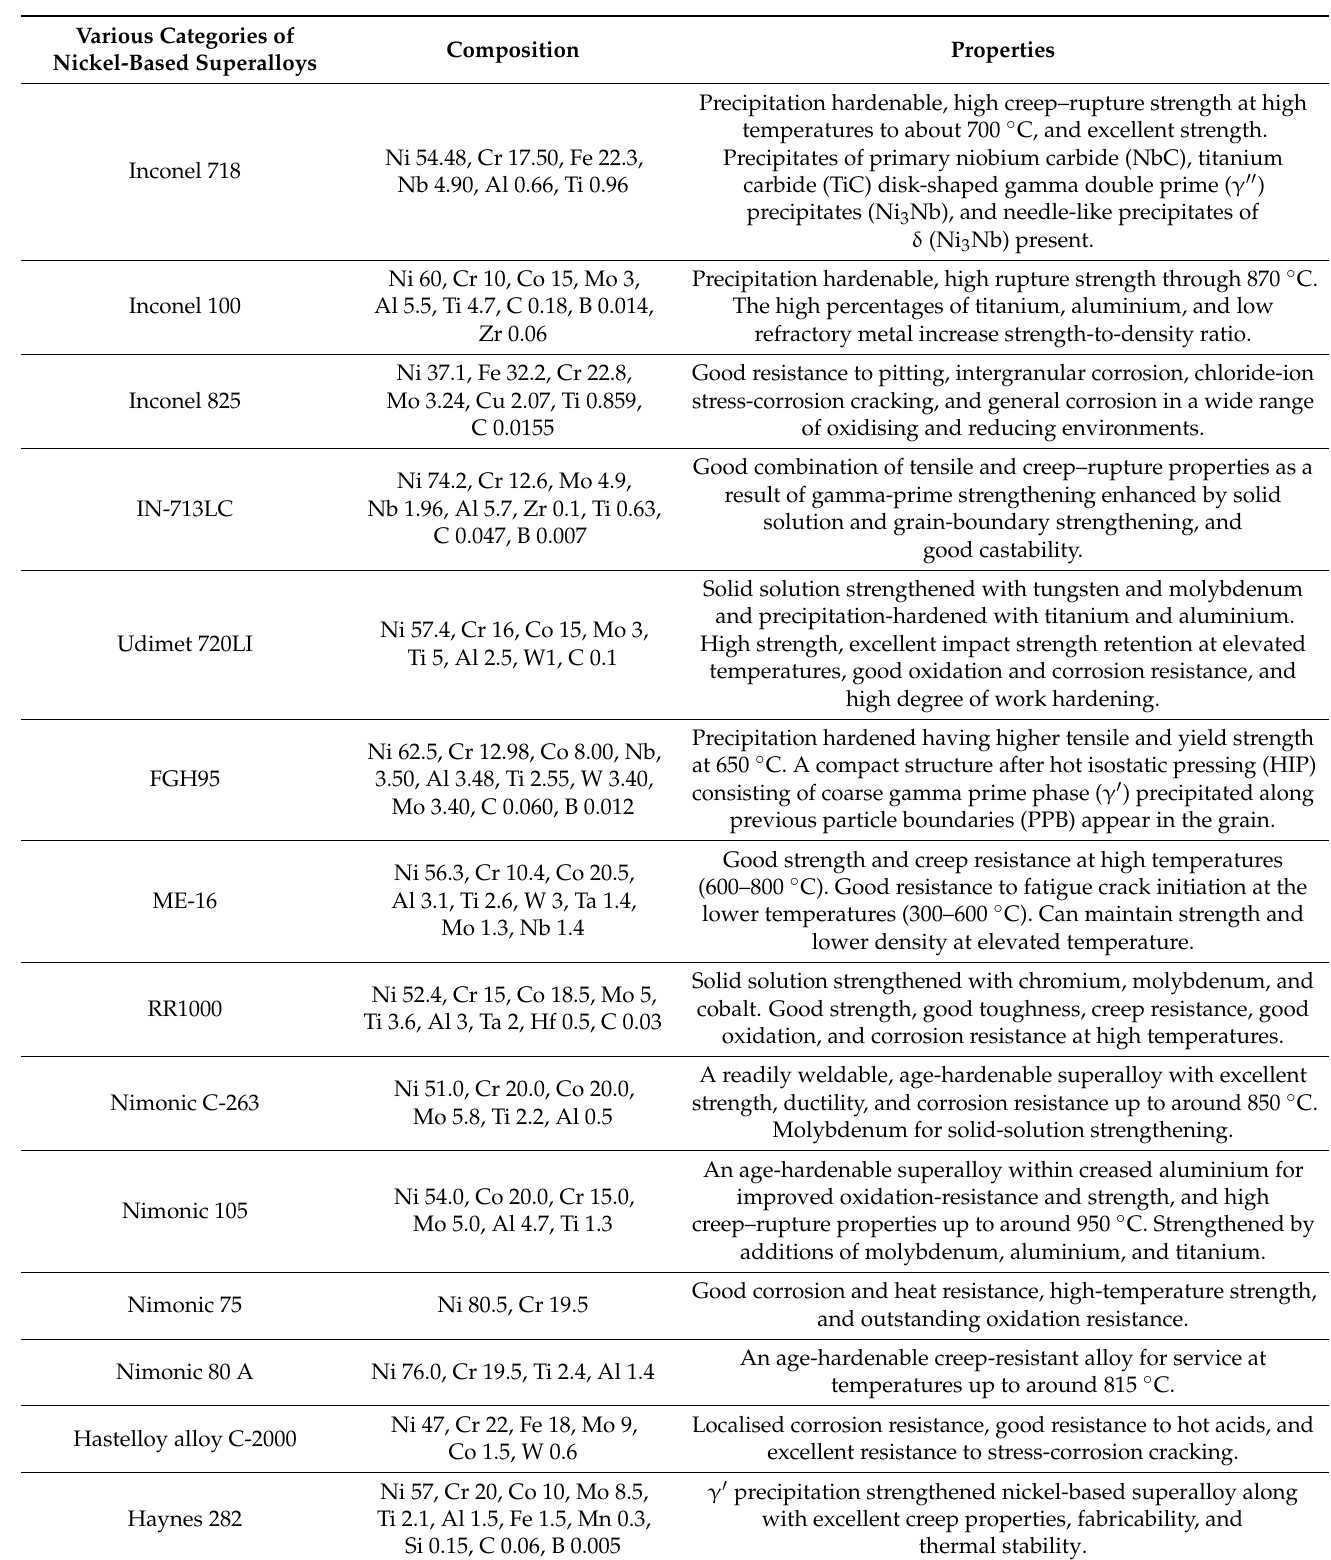
Table 1. Various categories, compositions, and characteristics of nickel-based